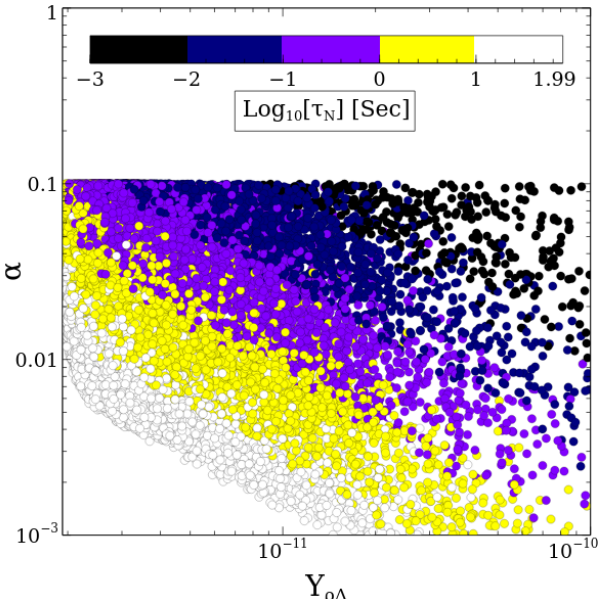
Figure 10 . Scatter plot in Y ρ ∆ − α plane after demanding DM relic density in 3 σ range. All the points satisfy BBN constraint from Y + D/H + 4 He/D and CMB spectral distortion p